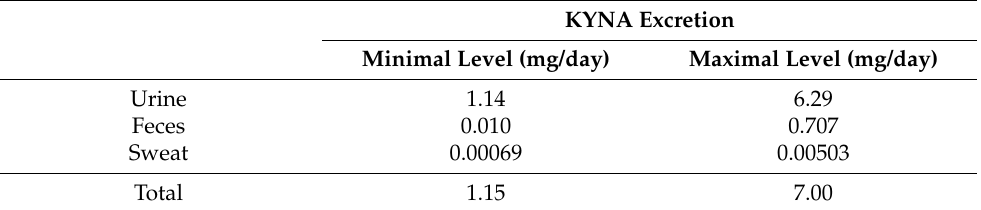
Table 1. Estimation of daily excretion of kynurenic acid (KYNA) by adult human. KYNA Excretion Minimal Level (mg/day) Maximal Level (mg/day) Urine 1.14 6.29 Feces 0.010 0.707 Sweat 0.00069 0.00503 Total 1.15